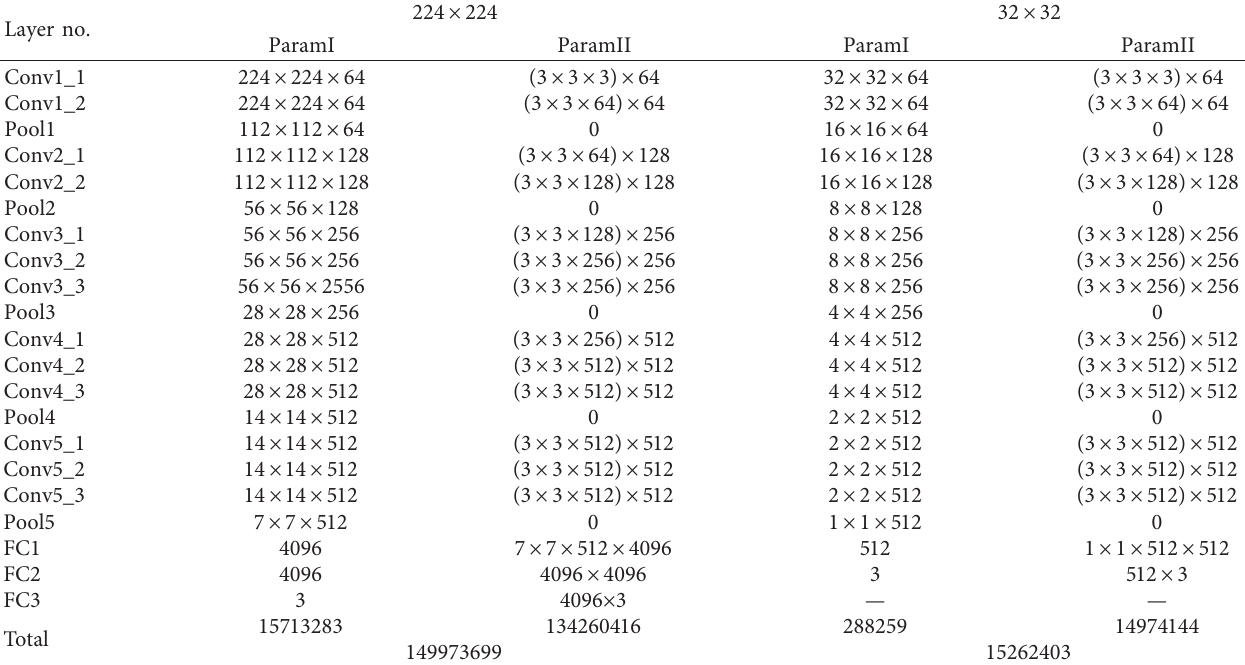
Table 5: Effects of different sizes of input signals on memory.